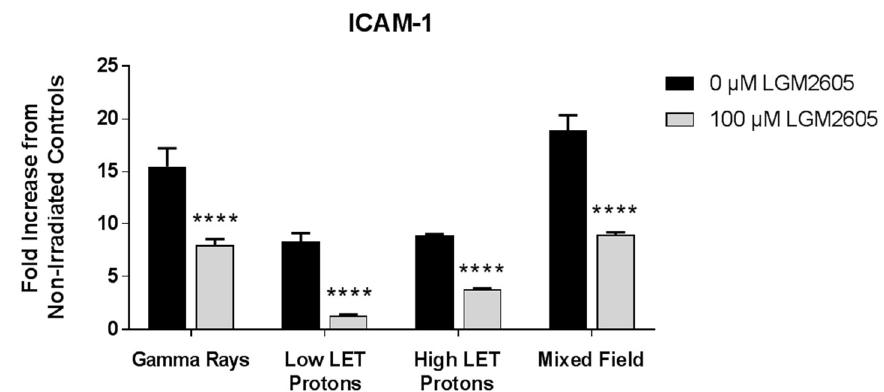
Figure 10. A comparative evaluation of ICAM-1 expression post radiation exposure (0.5 Gy). Fluorescent images of FAECs exposed to gamma rays, low LET protons, high LET protons, and mixed field gamma and proton radiation were quantified. Data are normalized to the respective non-irradiated controls and presented as fold increase over controls. Data are presented as mean ± SEM. Asterisks shown in figures indicate significant differences from FAECs exposed to 0.5 Gy radiation and treated with 0 µM LGM2605 (**** p < 0.0001).